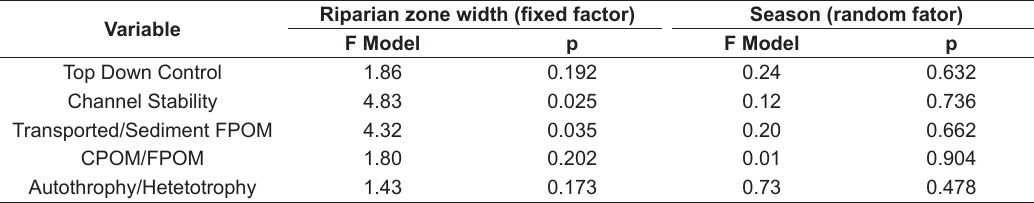
Table 6. Two-way ANOVA with fixed (riparian zone width) and random (season) factors for benthic macroinvertebrate functional feeding group (FFG) variable